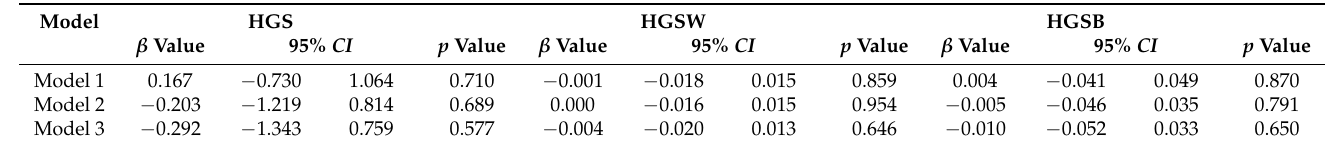
Table 4. Associations among serum DAO and skeletal muscle strength in middle-aged and older